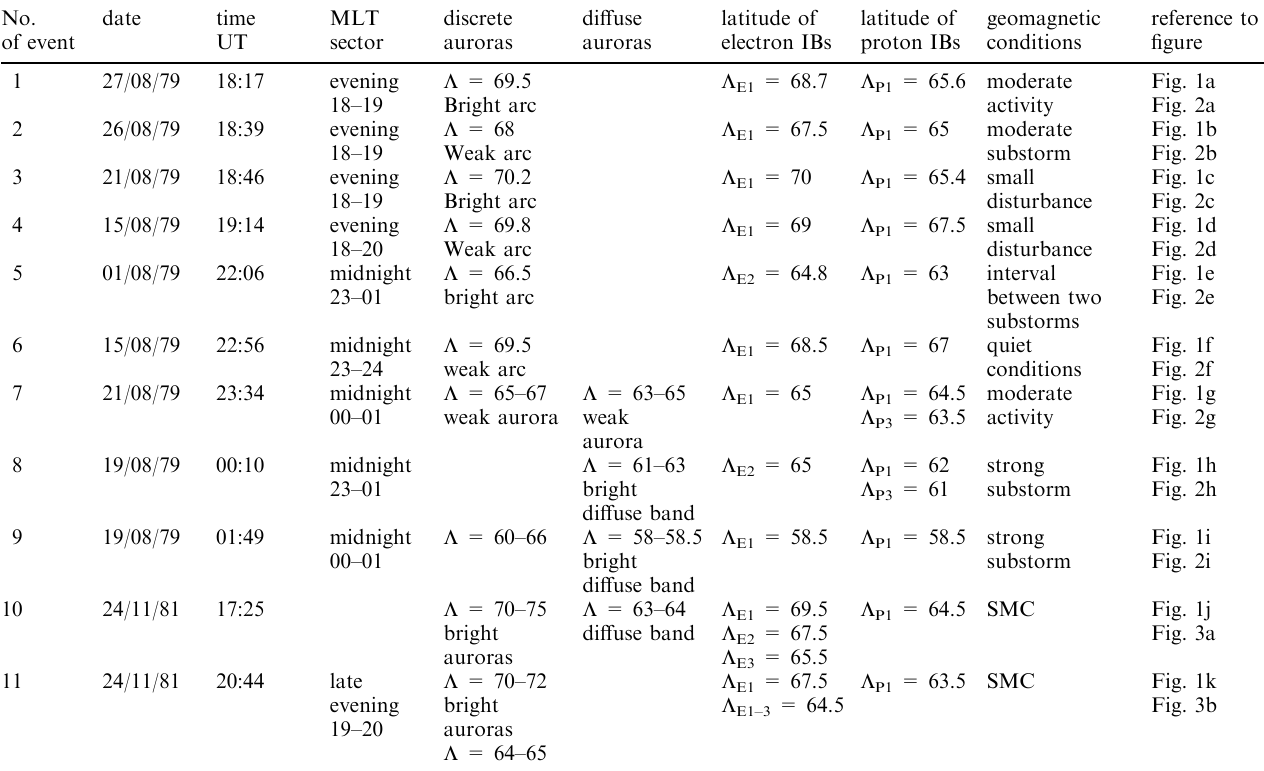
Table 2. Summary of observations